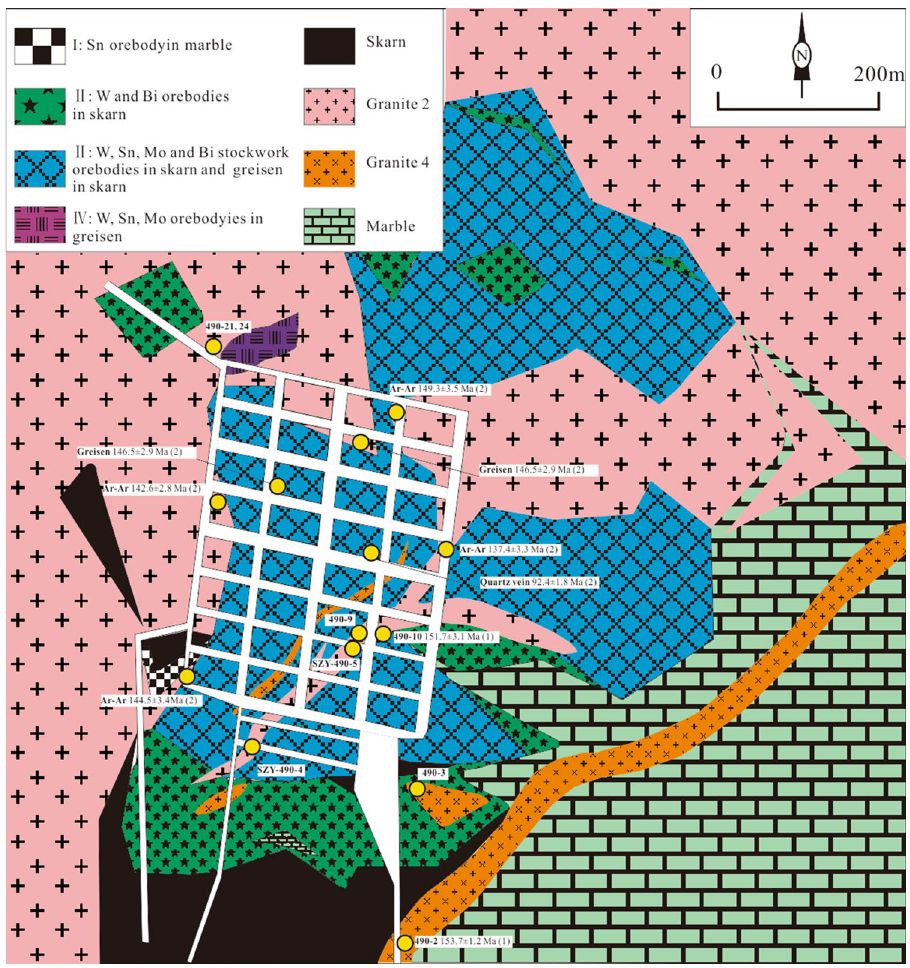
Figure 4. Sampling locations in Tunnel 490 (after Lu et al., 2003, copyright@Society of Economic Geologists, 2003) 39 . ( 1 ) zircon LA-ICP-MS U–Pb dates from this study; ( 2 ) muscovite Ar–Ar dates of the Qianlishan granites and Greisen from Yin et al., 2002 29